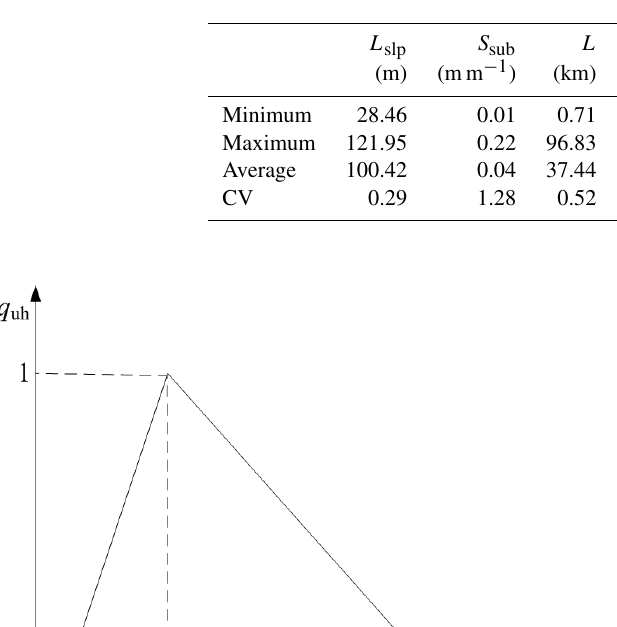
Figure 2. SWAT-EVENT model for the simulation of event-based flood data based on the initial conditions extracted from daily simulation results produced by the original SWAT model. Table 2. Geographic features of sub-basins for the Wangjiaba (WJB) catchment.